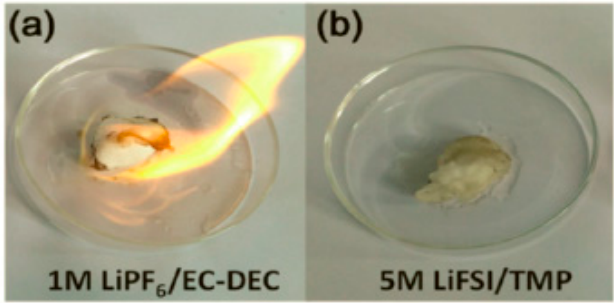
Figure 7. ( a ) Flammability tests of 1 M LiPF 6 /EC-DEC and ( b ) 5 M LiTFSi/TMP electrolyte [35]. Figure 7. Flammability tests of 1 M LiPF 6 /EC-DEC and 5 M LiTFSi/TMP electrolyte [35]. Reprinted Reprinted with permission, © with permission, © 2018.